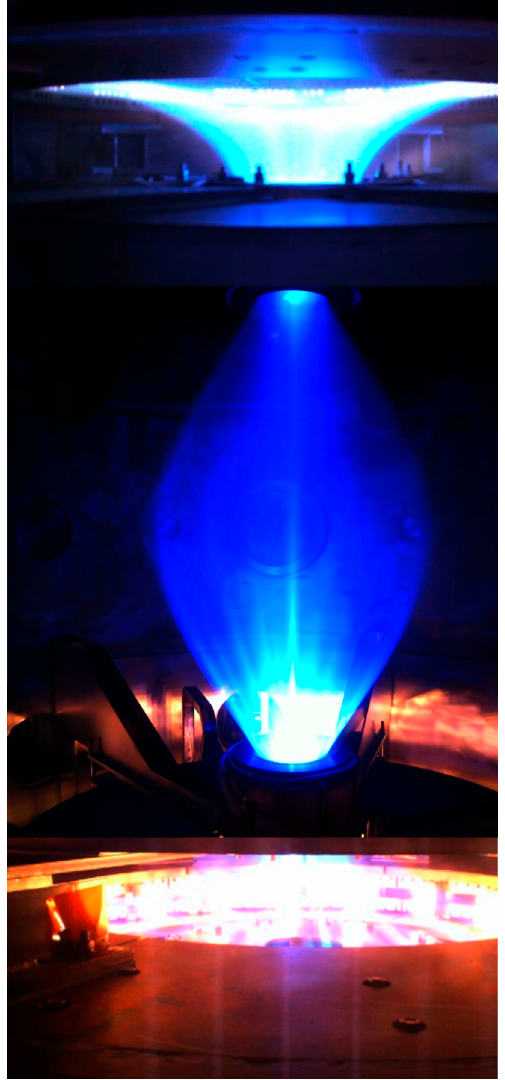
Figure 17. Comprehensive representation of the PROTO-SPHERA plasma center post, obtained by merging three images captured during a typical experiment by high resolution cameras.